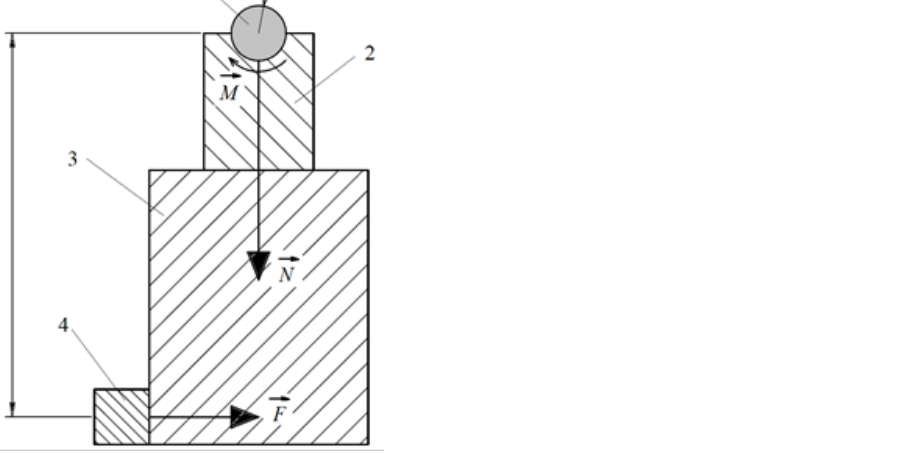
Figure 1. Friction scheme. 1 — sample; 2 — counter-body; 3 — pendulum; 4 — strain gauge. M — frictional moment; N — force acting on the counter body and the pendulum from the side of the sample; F — force acting on the pendulum from the strain gauge; L — distance from the axis of rotation to the axis of symmetry of the strain gauge.